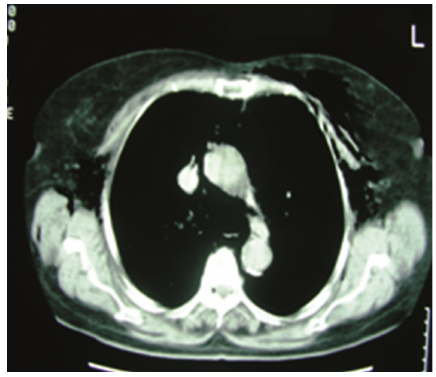
Figure 3: Transverse CT image of the chest revealing bilateral di ff use subcutaneous emphysema and pneumomediastinum. Free air is noted at the anatomic region of the aortic arch and the descending thoracic aorta.